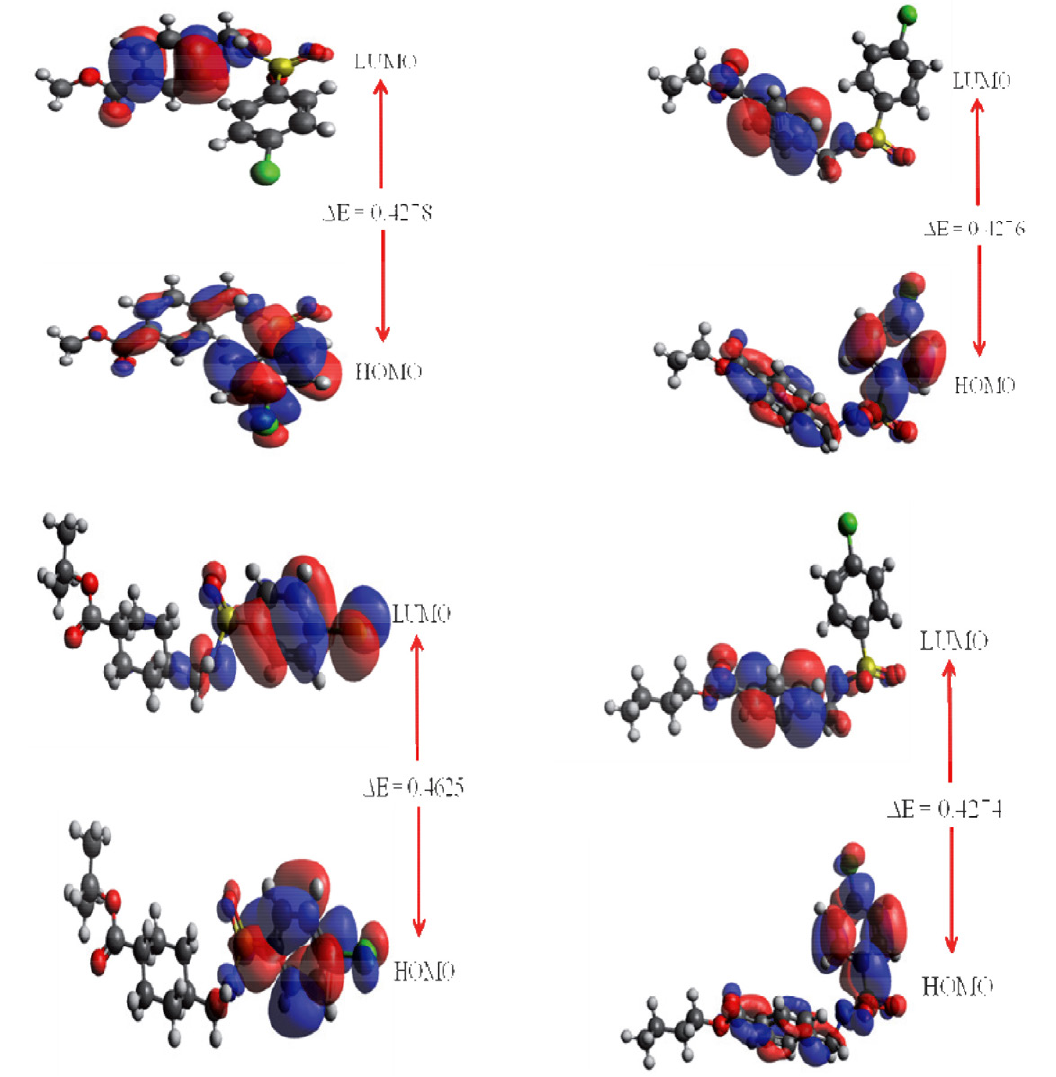
Figure 10. HOMO-LUMO energy diagram of synthesized esters